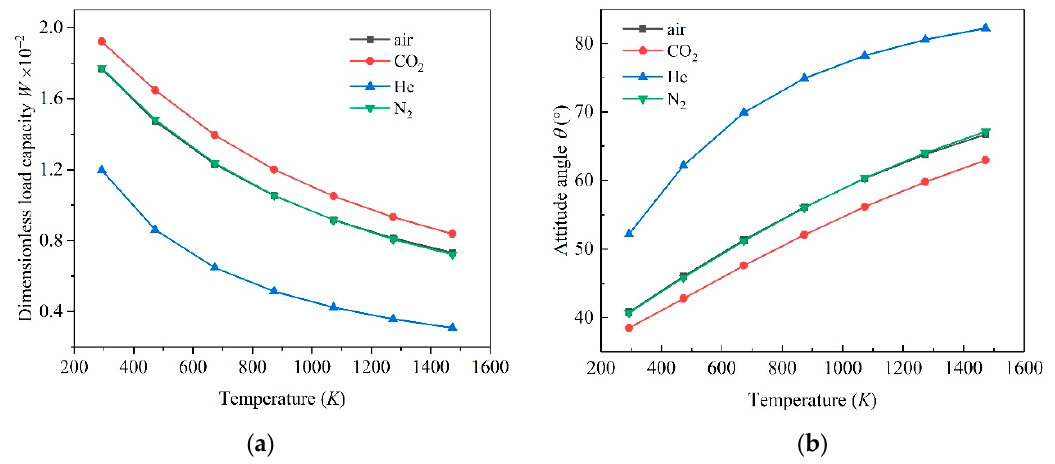
Figure 6. Influence of temperature on load capacity ( a ) and attitude angle ( b ).